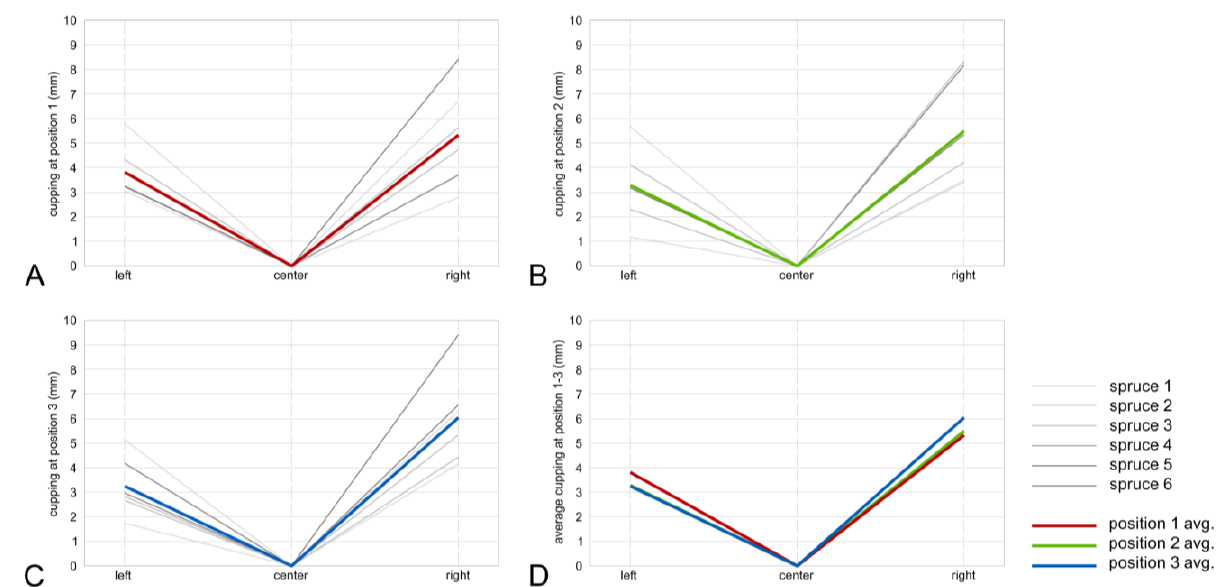
Figure 9. Spruce cupping in cutline 1—bottom ( A ), cut line 2—middle ( B ), cut line 3—top ( C ), and all averaged thicknesses ( D ).